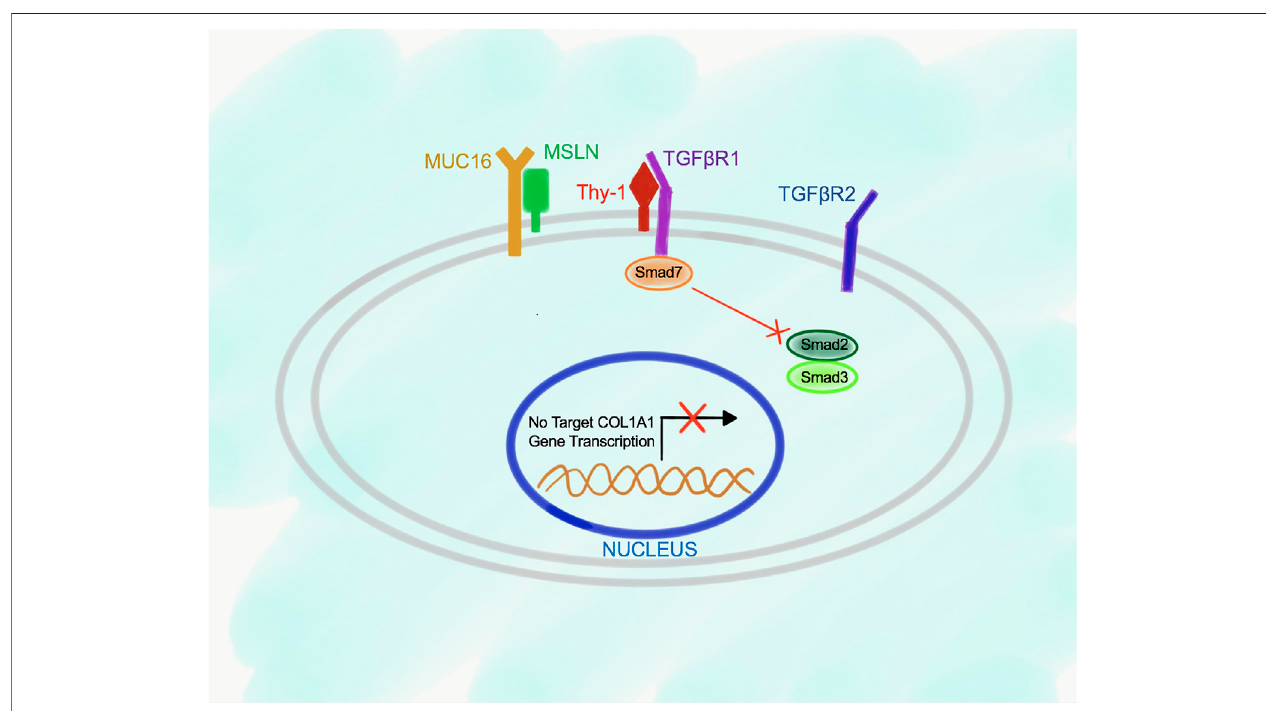
FIGURE 2 | Proposed model of Msln-Muc16 and Thy-1-TGF β RI binding in resting wild type aPFs. Msln and Muc16 form a complex in resting aPFs. Thy-1 and TGF β RI form a complex. Binding of Thy-1 to TGF β RI prevents TGF β 1 signaling, and retains Smad7 at the C-terminus of the TGF β RI.